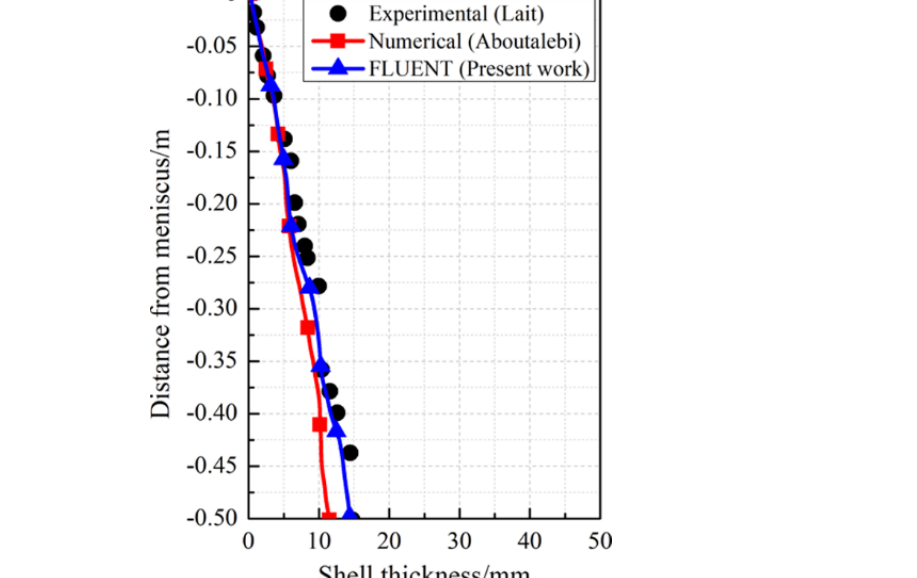
Figure 10. Electromagnetic characteristics in the central plane of the CSP mold: ( a ) magnetic flux density, ( b ) induced current density, and ( c ) electromagnetic force.